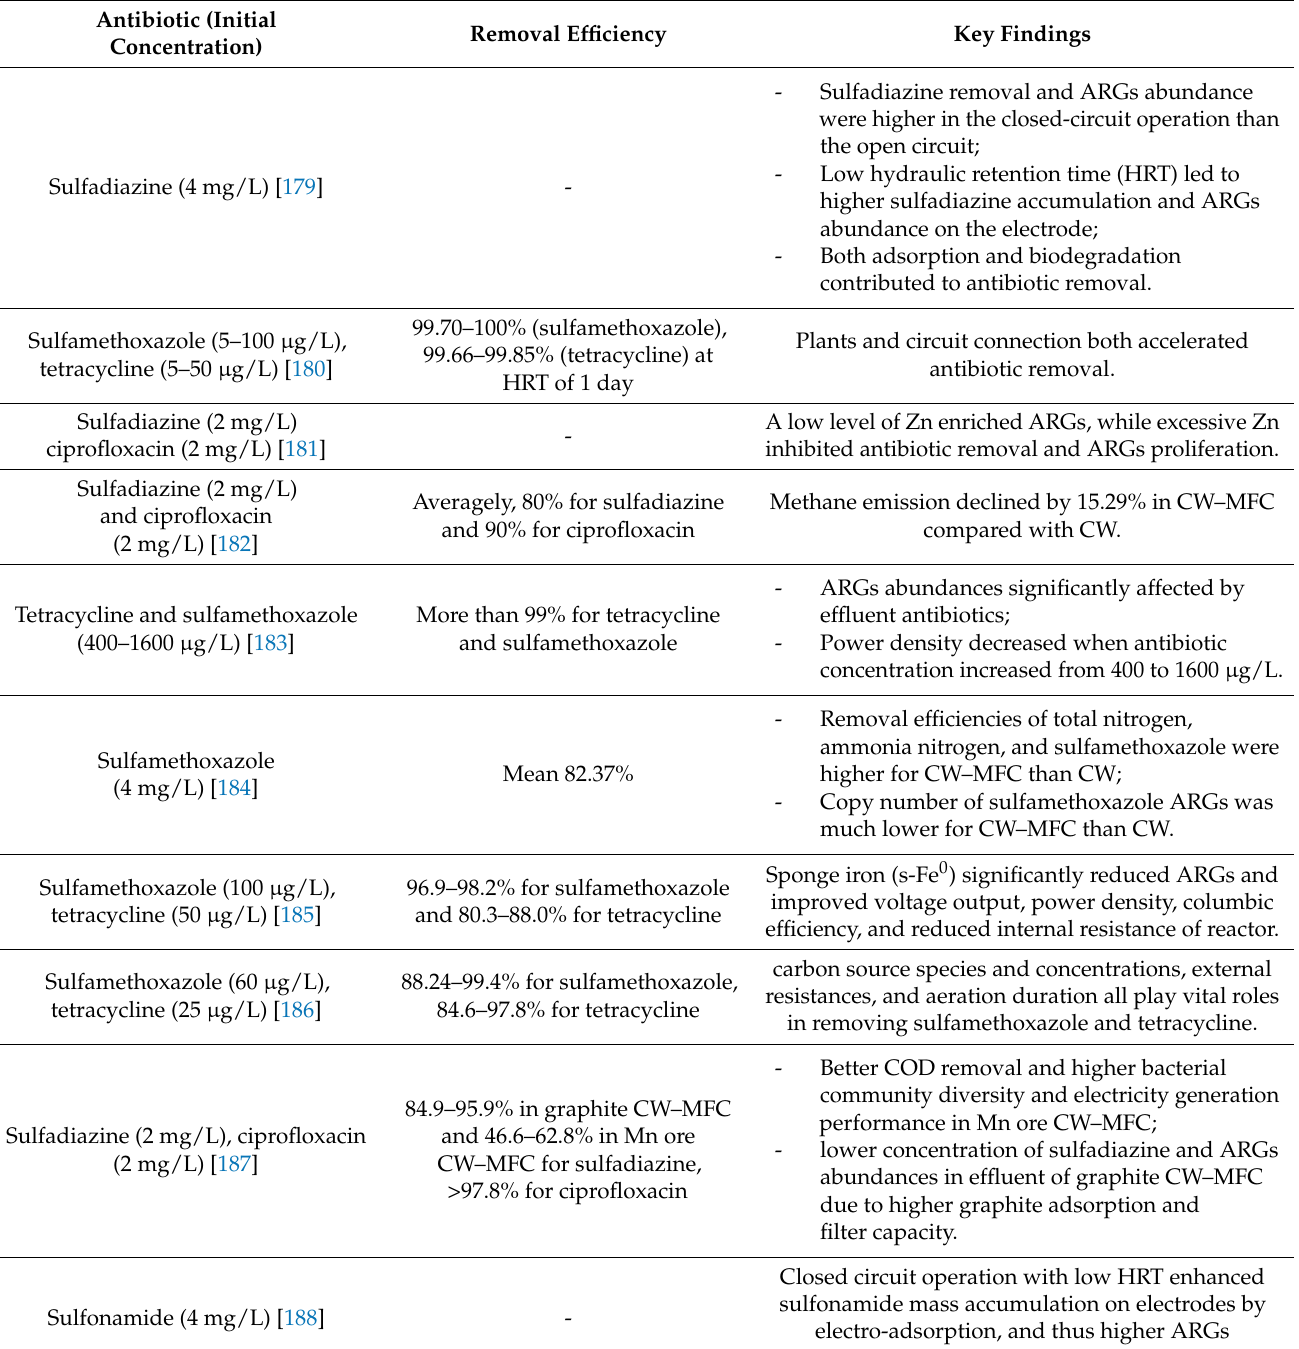
Table 4. Hybrids of constructed wetlands coupled with microbial fuel cells (CWs–MFCs) for antibiotic